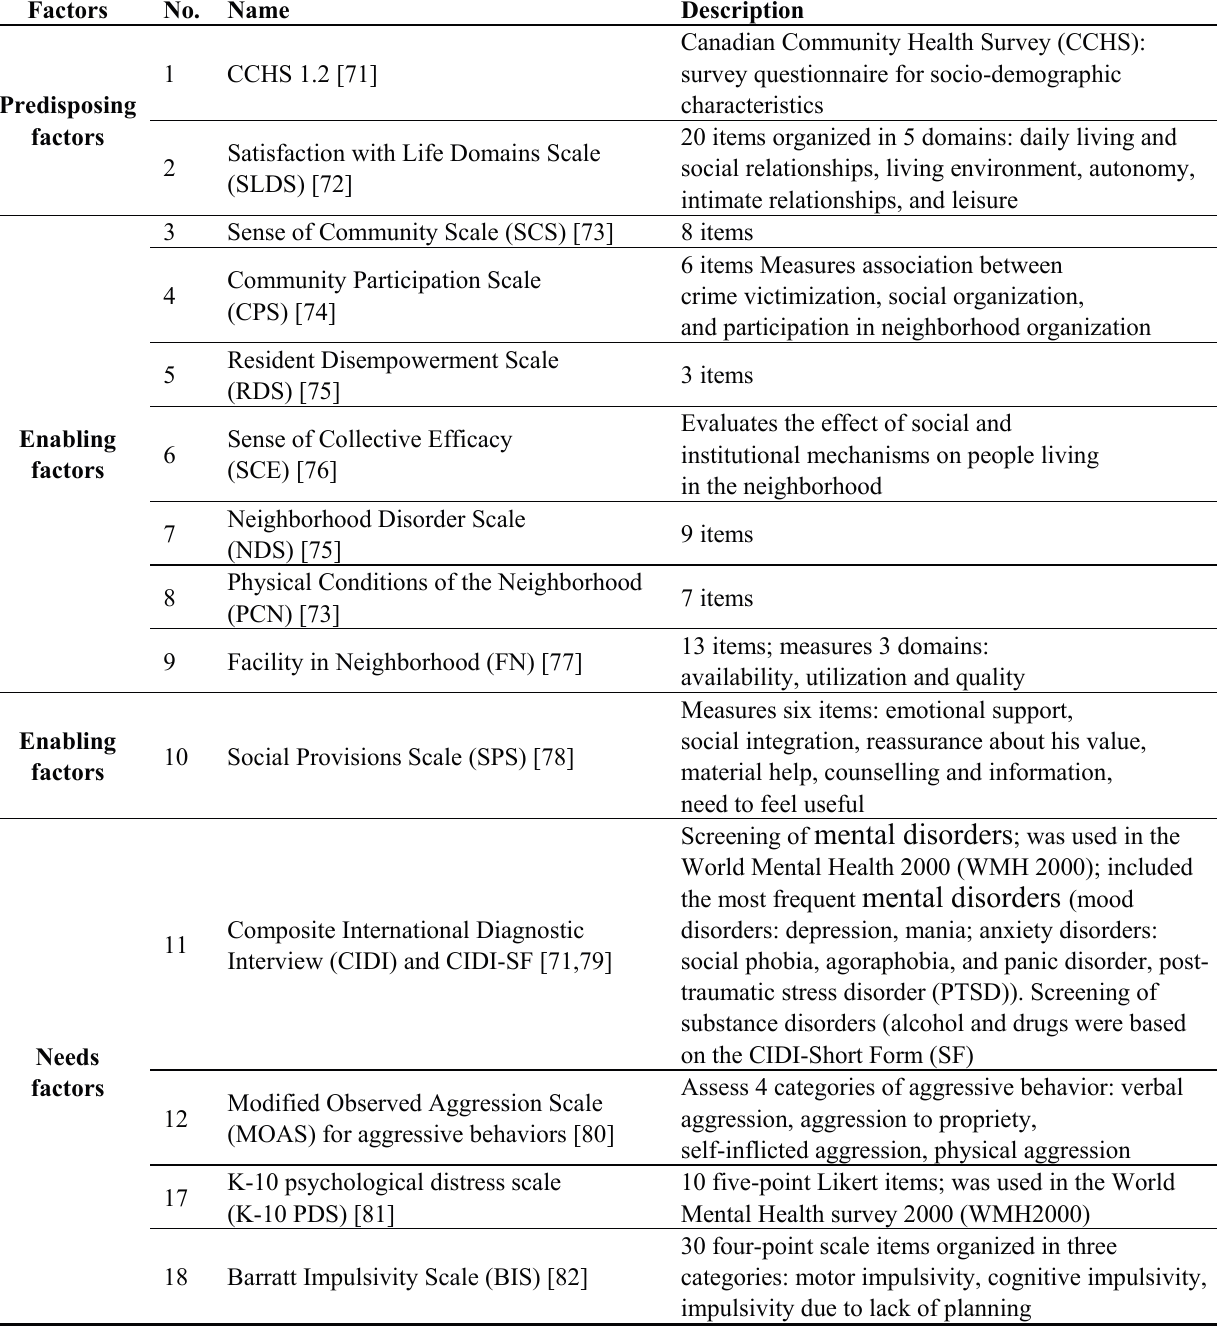
Table 1. Measuring